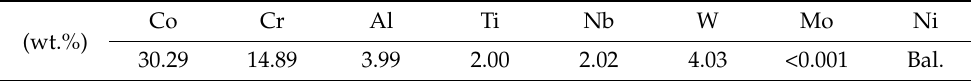
Table 1. Composition of SJTU-1 alloy.